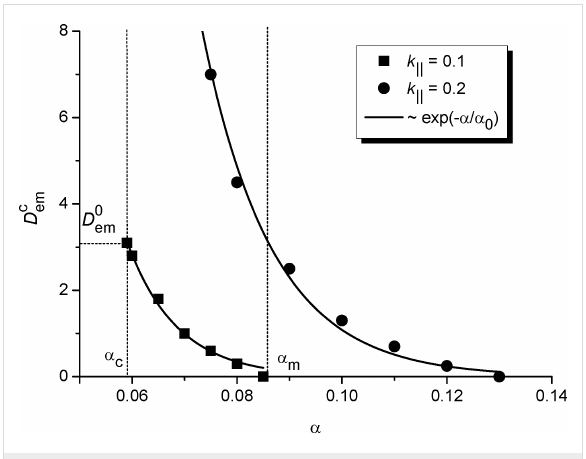
Figure 8: Dependence of the critical value of the electrical field strength on the adsorption coefficient α at different values of the vertical diffusion coefficient k ∥